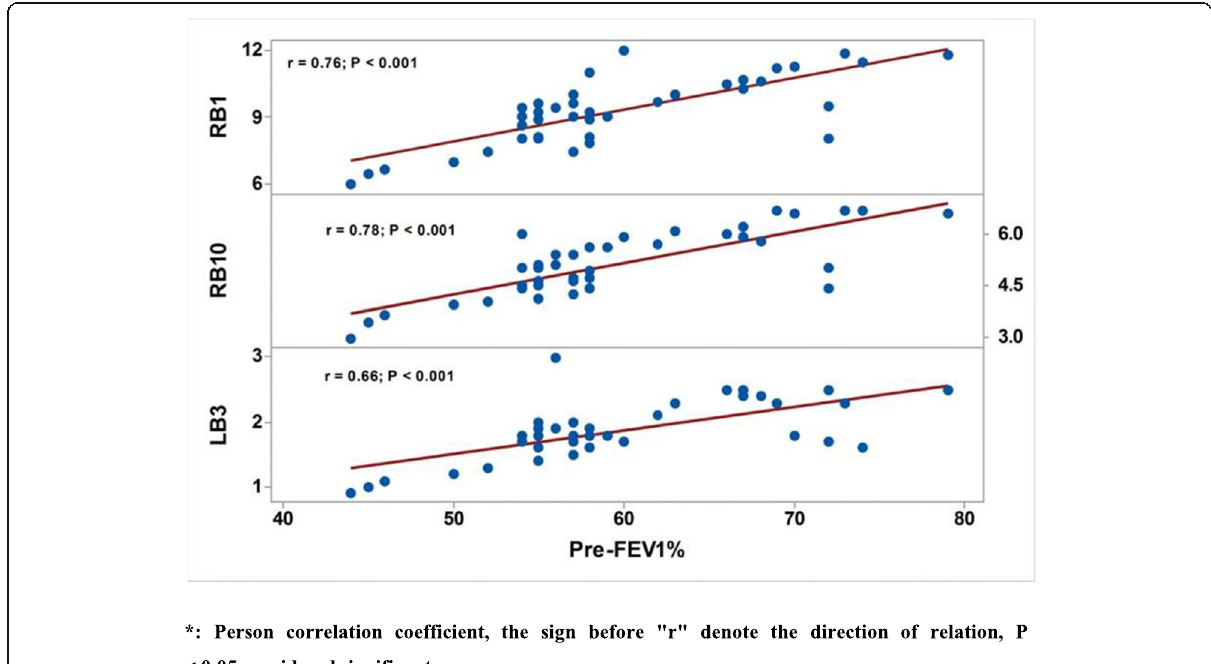
Fig. 1 Correlation of FEV1% and intraluminal size during expiratory stage. * Pearson correlation coefficient, the sign before “ r ” denotes the direction of relation, P <0.05 considered